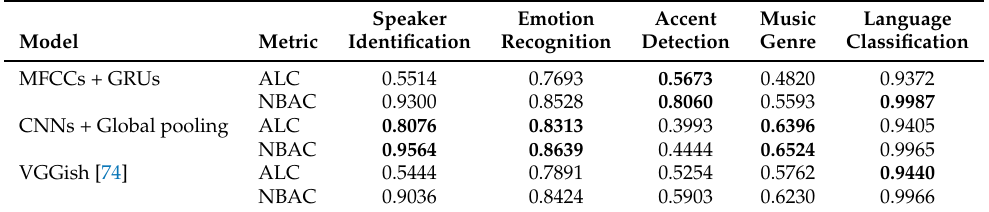
Table 7. Audio: Performance of various architectures on the training